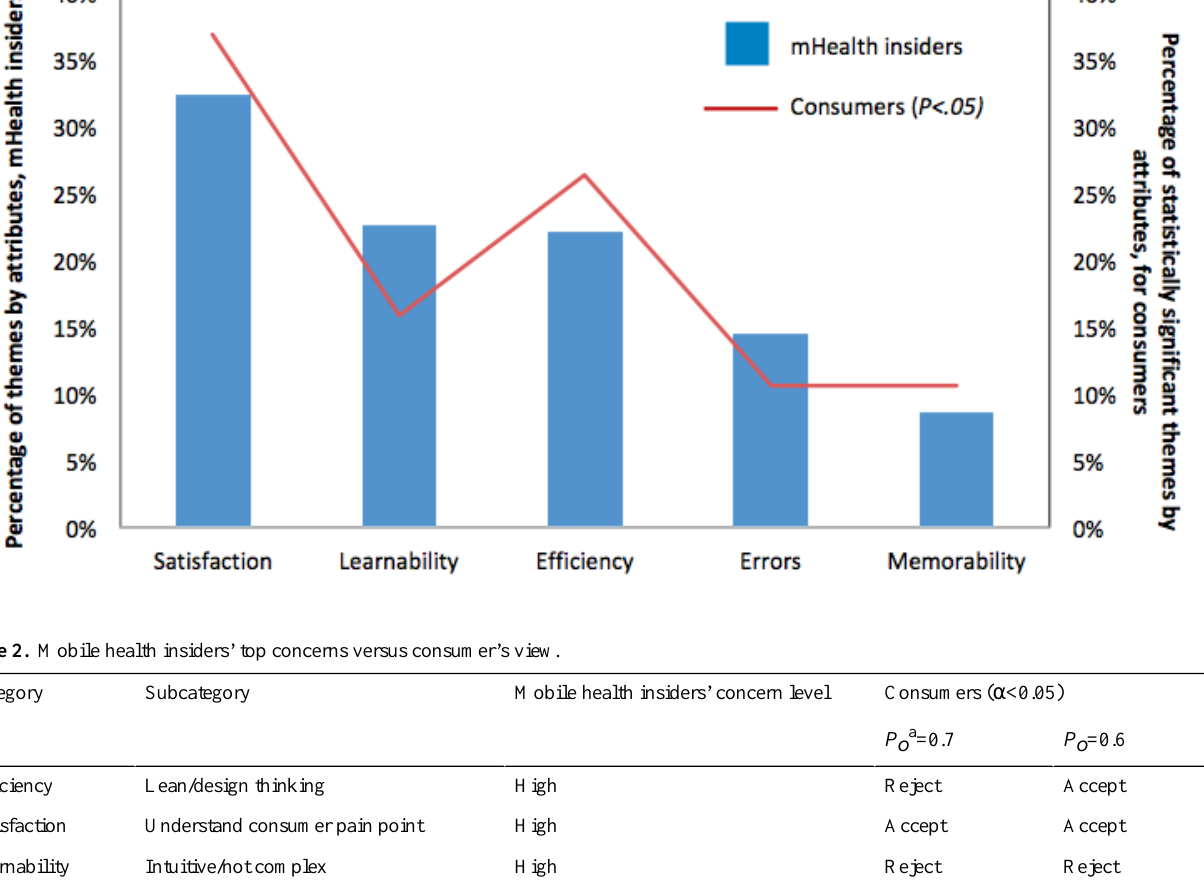
Figure 12. mHealth insider and consumer alignment study.